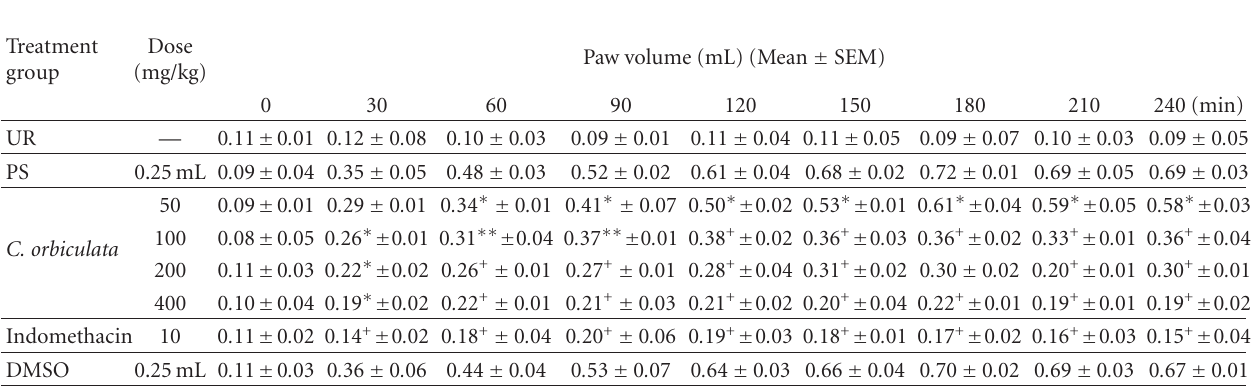
Table 3: E ff ect of leaf methanol extract of Cotyledon orbiculata on carrageenan-induced oedema in the right hind paw of rat.